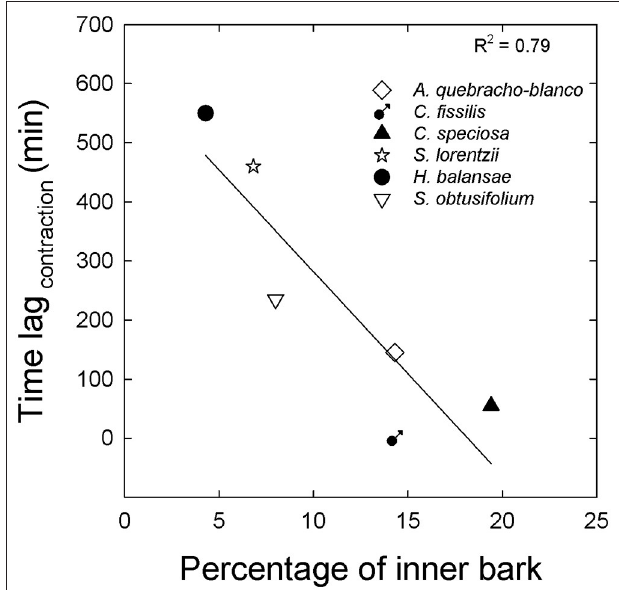
FIGURE 5 | Lag time between inner bark contraction and sapwood contraction in relation to the percentage of inner bark for three typical species from moist forest (close symbols) and three typical species from dry forest (open symbols). The line in A is the linear function fitted to the data y = 623–34x; p <